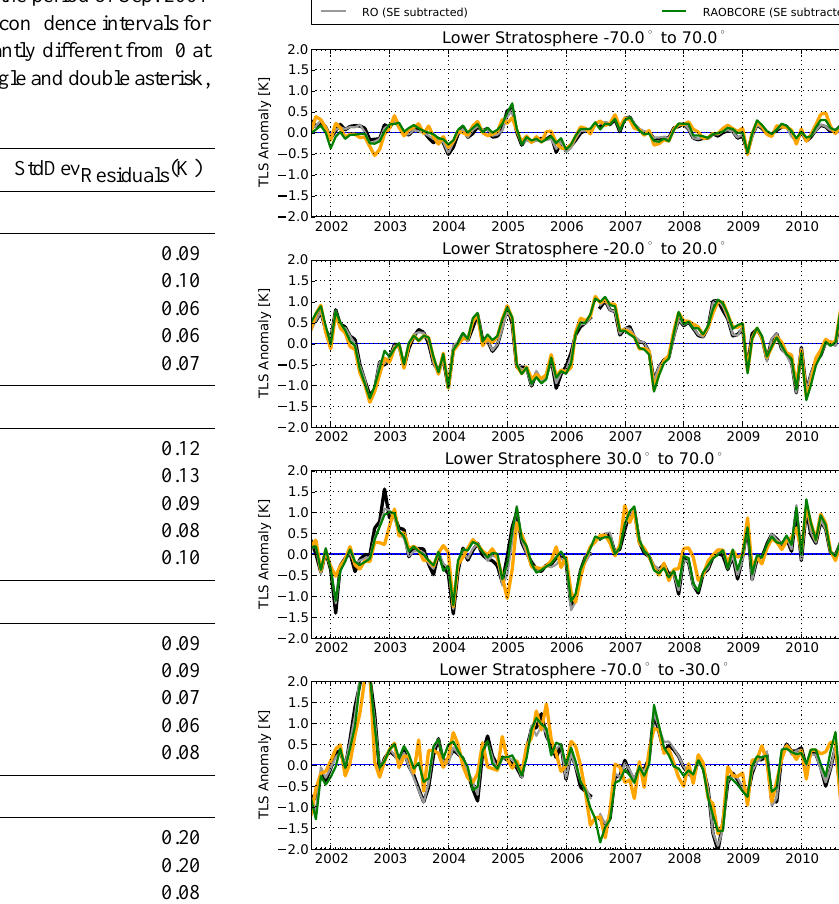
Fig. 6. TLS anomalies before/after subtracting the sampling error for RO (black/grey) and for RAOBCORE (orange/green). Shown for quasi-global region, tropics, and for NH/SH extratropics (top to bottom).